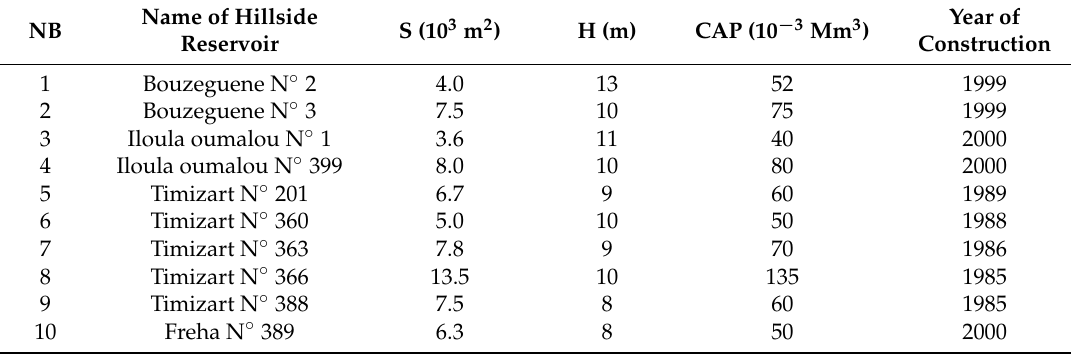
Table 2. Characteristics of the hillside reservoirs of the Tizi-Ouzou region (Algeria) described by the authors of [39] and considered in this